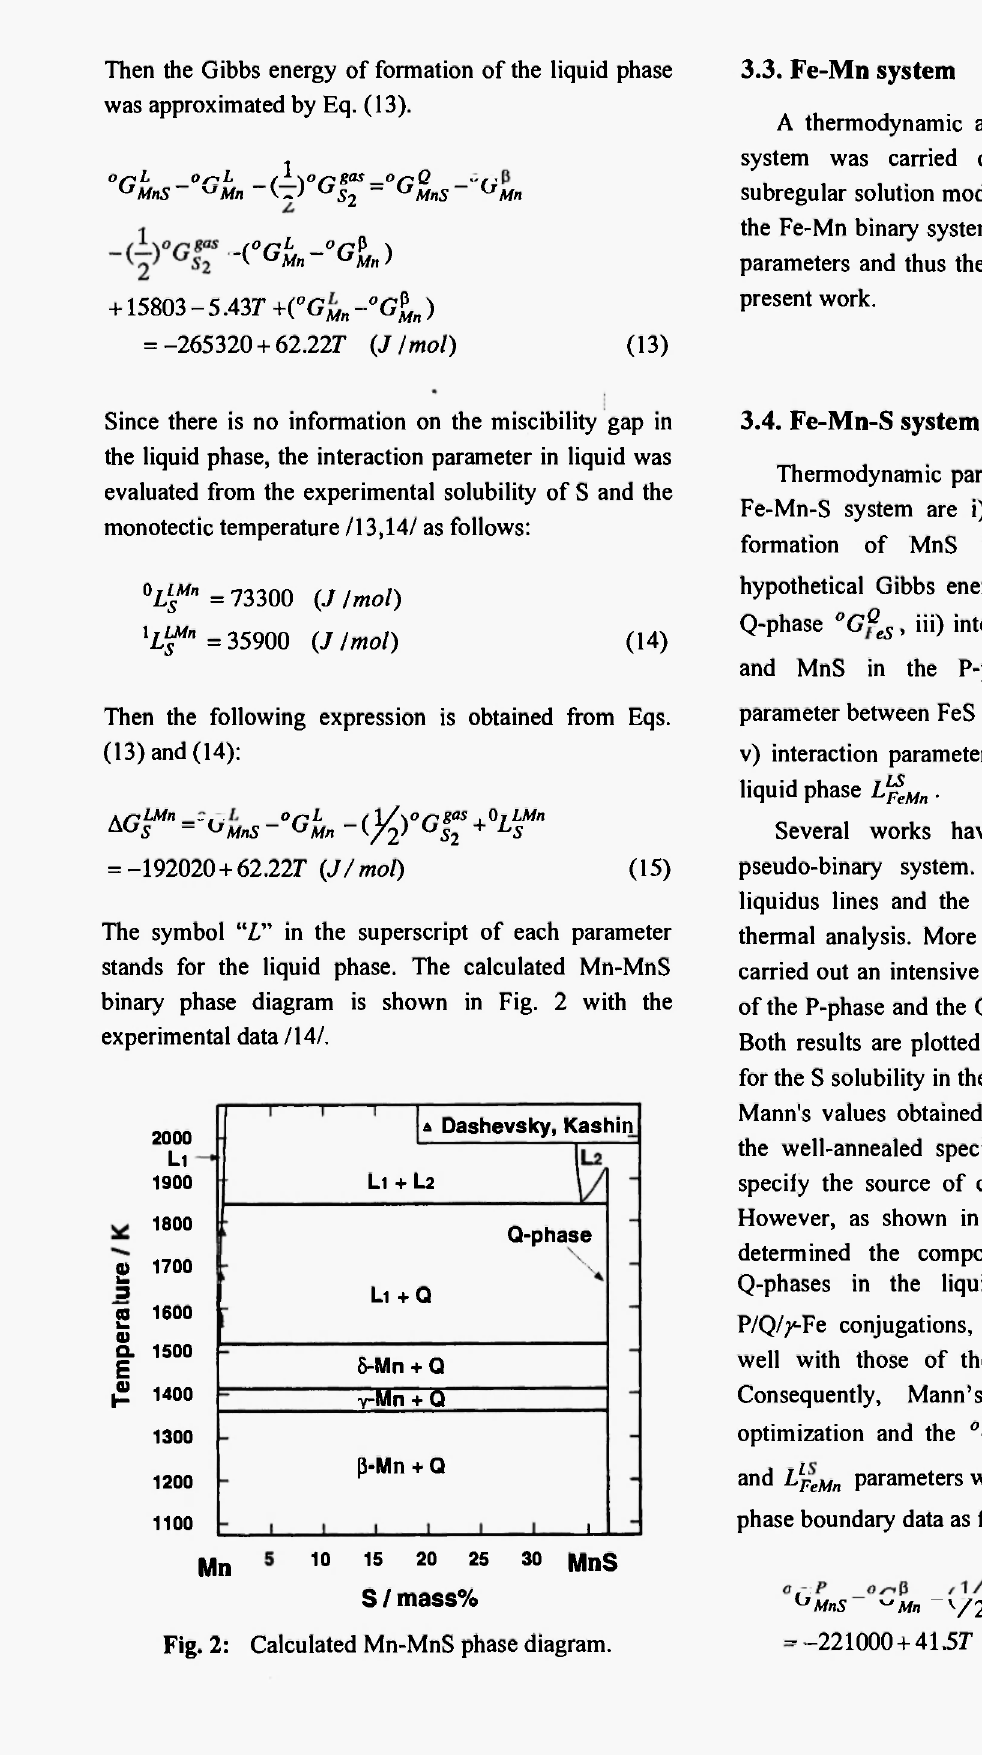
Fig. 2: Calculated Mn-MnS phase